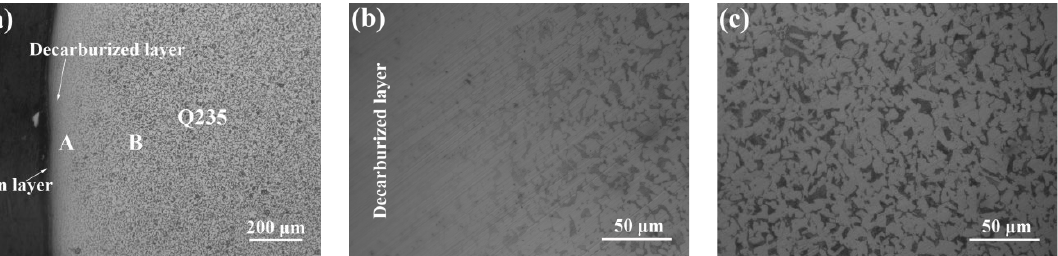
Figure 3. ( a ) Optical micrograph of the cross-section of the galvanized Q235, ( b ) magnified image of region A, and ( c ) magnified image of the region B.